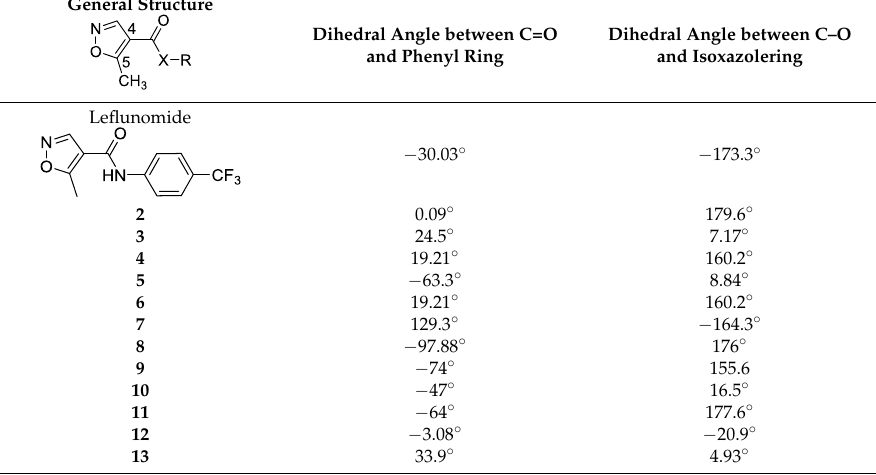
Table 2. Dihedral angle between C=O and phenyl ring, and Dihedral angle between C–O and isoxazole ring.